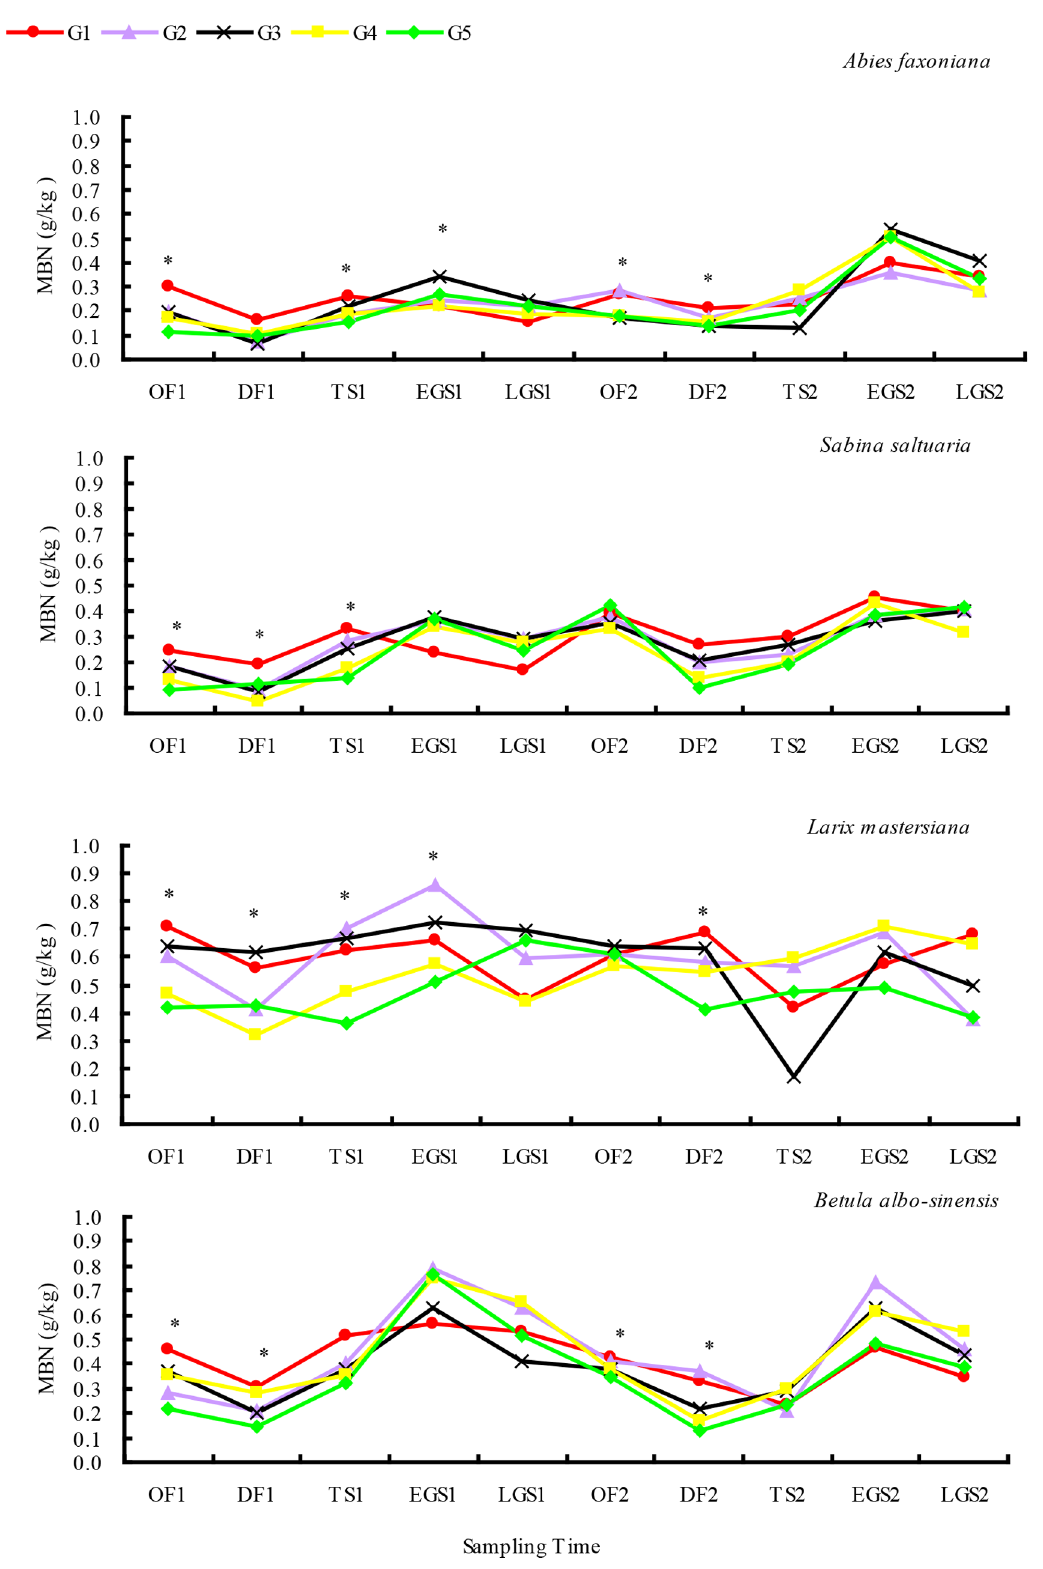
Figure 6. MBN during litter decomposition from gap center to closed canopy at different decomposition stages over 2 years (mean ± SD , n =5). The symbols ‘‘*’’ indicate the significant difference among treatments (LSD’s multiple range test; P , 0.05). Abbreviations: MBN =microbial biomass nitrogen; OF=onset of freezing stage; DF=deep freezing stage; TS=thawing stage; EGS=early growing season; LGS=late growing season; G1=gap 1, gap center south; G2=gap 2, gap center north; G3=gap 3, canopy edge; G4=gap 4, expanded edge; G5=gap 5, closed canopy.